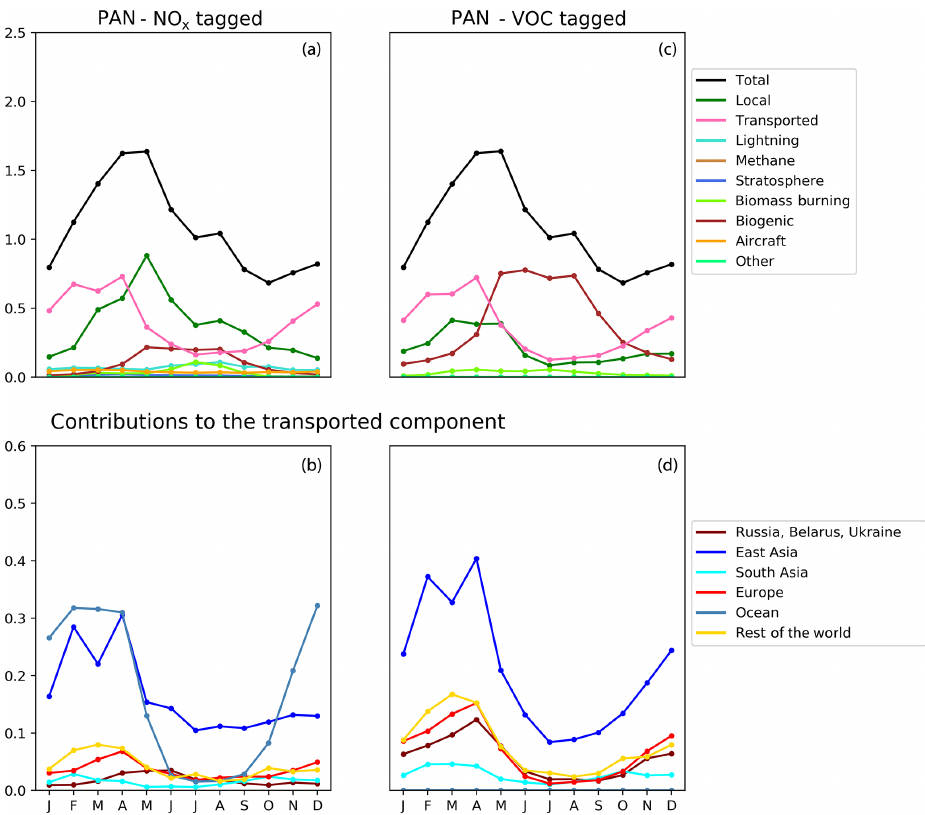
Figure 10. Seasonal cycle of column-integrated lower tropospheric PAN (10 − 15 molec.cm − 2 ) in the HTAP Tier 2 receptor region “North West United States”. The lower troposphere is defined here as all model levels between 800 and 500hPa. NO x tagging is shown in panels (a) and (b) , and reactive carbon tagging is shown in panels (c) and (d) . Panels (a) and (c) show the total monthly mean PAN (black line) as well as the local anthropogenic component, the long-range transported anthropogenic component, and the natural components. Panels (b) and (d) show the individual Tier 1 source regions responsible for the long-range transported component of PAN. Table 4. Change in the contribution of reactive carbon sources to tropospheric and Northern Hemisphere (NH) surface ozone in response to a 25% increase in the imposed surface mixing ratio of methane. Absolute changes and percentage changes are both